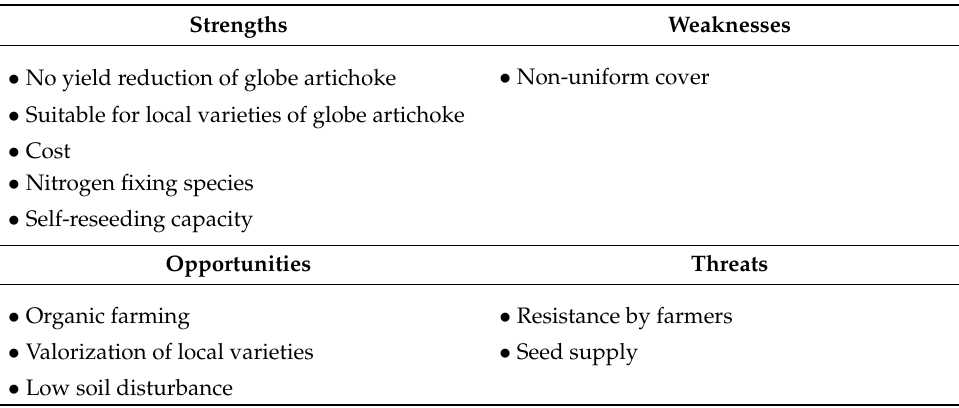
Table 8. SWOT analysis related to the use of subterranean clover as living mulch for weed manage- ment in globe artichoke